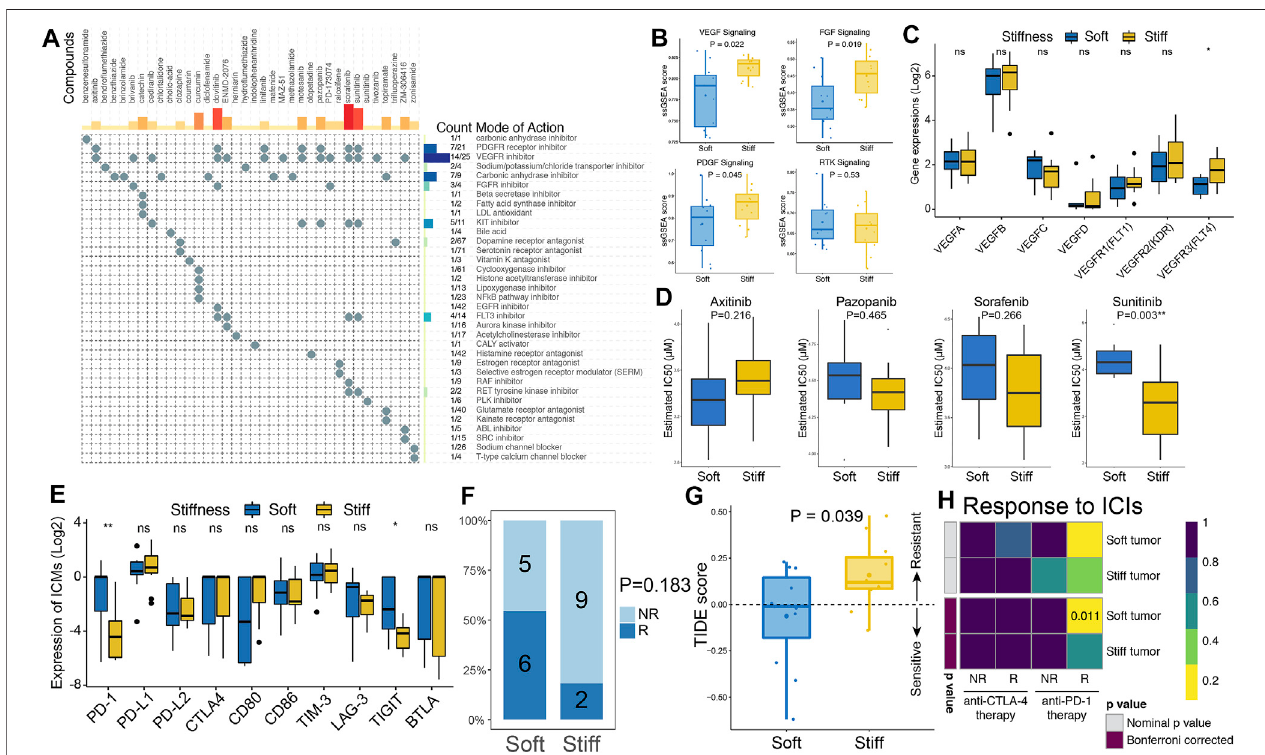
FIGURE7| PredictionofPAtargetedtherapyresponse. (A) CMap-basedexplorationofcandidatedrugsandmolecularpathwaysthatcanbeusedfortreatmentof stiff PAs based on the SRGs. The MoA analysis revealed 35molecular pathways targeted by 36 compounds. (B) Comparisons of the ssGSEA enrichment scores of the VEGF,PDGF,FGFandRTKsignalingpathwaysbetweensoftandstifftumors. (C) Comparisonsofthegeneexpressionofstructurallyrelatedfactorsandreceptorsofthe VEGFfamilybetweensoftandstifftumors. (D) ComparisonsoftheIC50valuesofaxitinib,pazopanib,sorafenib,andsunitinibastreatmentbetweensoftandstiffPA samples, as estimated by the pRRophetic algorithm based on GDSC data. (E) Comparisons of the gene expression of ICMs between soft and stiff tumors. (F) Comparisons of the proportions of nonresponders and responders to immunotherapy between the soft and stiff tumor groups. NR, nonresponder; R, responder. (G) Comparisons of the TIDE score between soft and stiff tumors. A TIDE score < 0 indicates sensitivity to immunotherapy, and a TIDE score > 0 indicates resistance to immunotherapy. (H) Subclass mapping analysis for predicting the likelihood of response to ICI treatments in soft and stiff PAs.